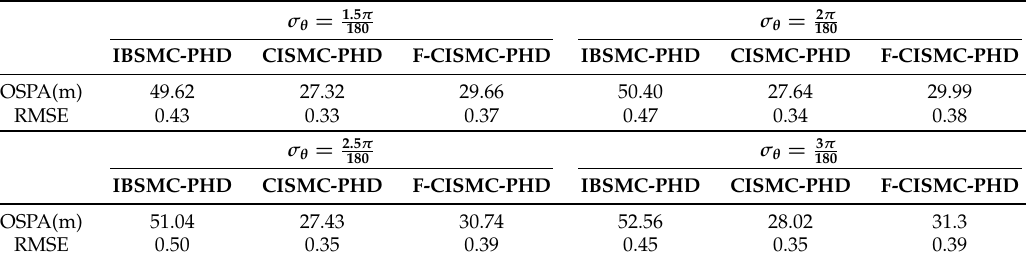
Table 7. Tracking Performance over different σ θ